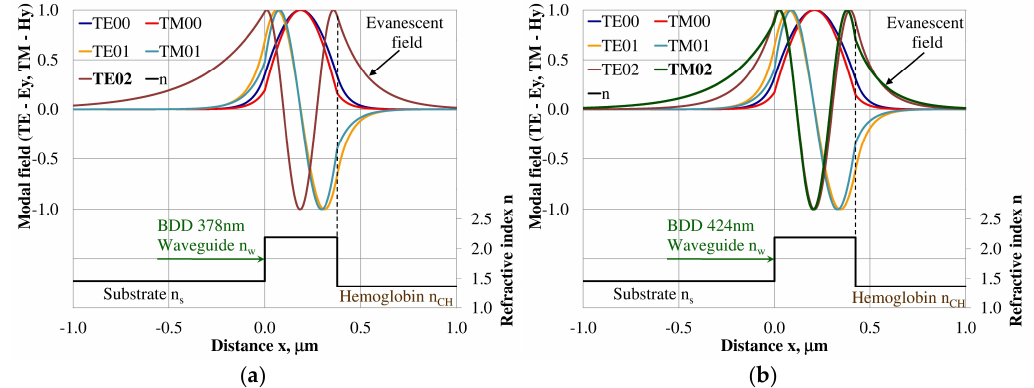
Figure 10. The modal field distribution in the multi- mode BDD-based waveguide: ( a ) TE02 for maximum dN eff /dn cH , and ( b ) TM02 for maximum dN eff /dn cH .